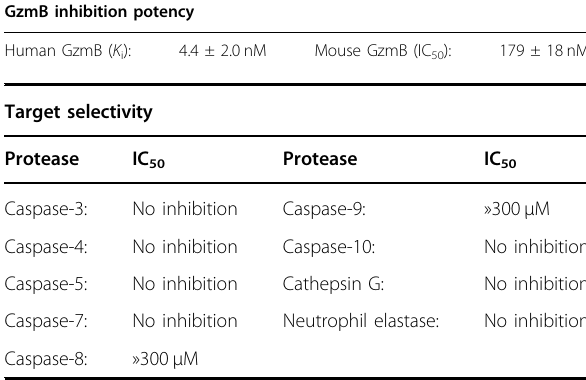
Table 1 Biofunctional characteristics of VTI-1002 GzmB inhibition